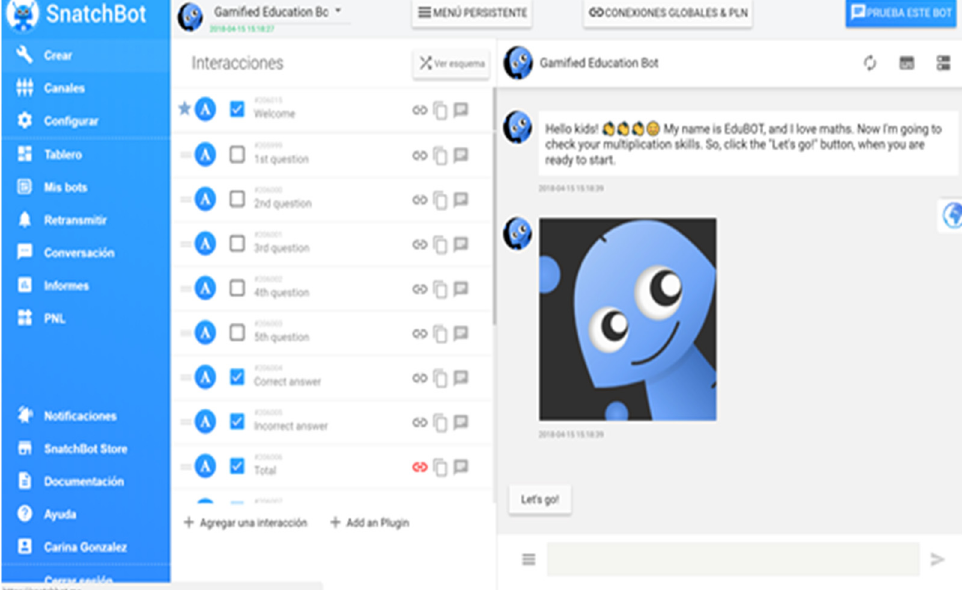
Figure 2. Gamification model canvas for our prototype. Adapted from Jimenez (2013).